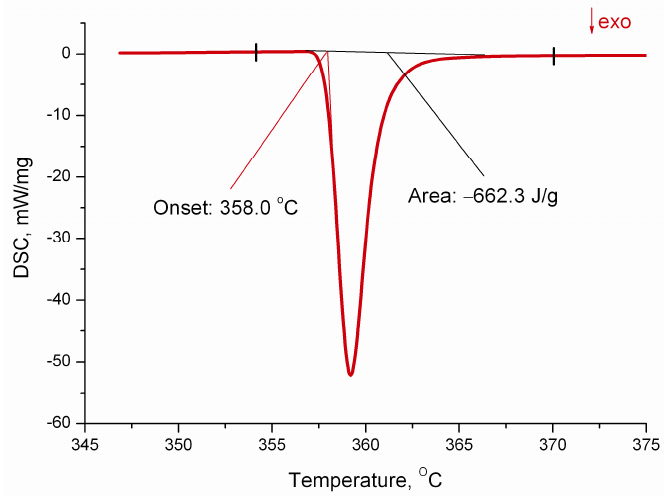
Figure 2. Differential scanning analysis curve for Ag 2 [PtCl 4 ].